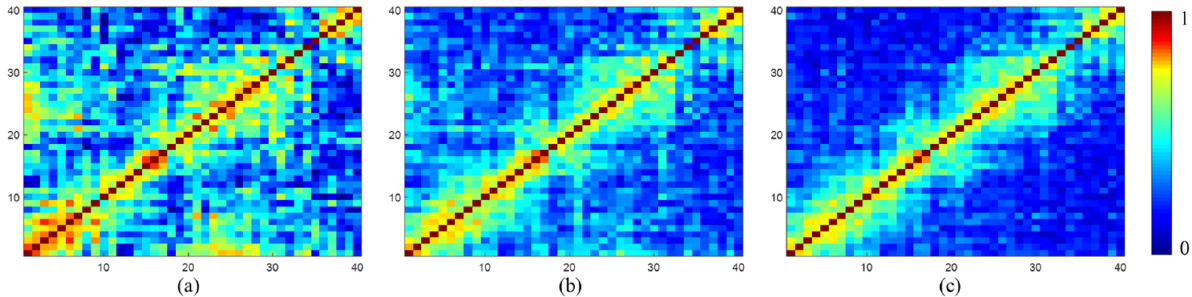
× pixels. ( a ) Sample coherence magni- γ γ  . ( c ) Corrected coherence magnitude with the